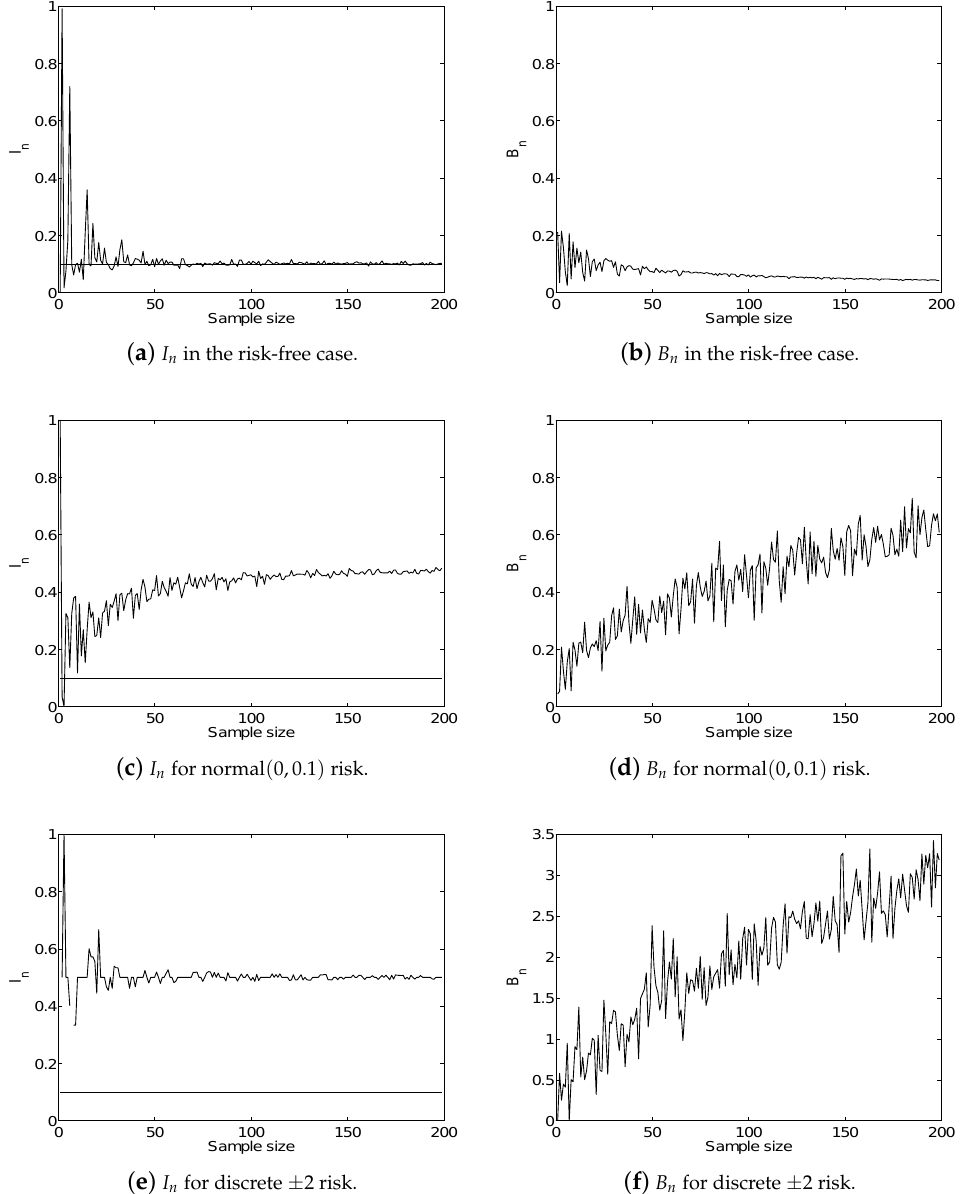
Figure 2. The risk-detection algorithm via the asymptotics of the pivot I n and its supporter B n , with the horizontal line in the three left-hand panels at the height of I h to be defined by Equation (4)